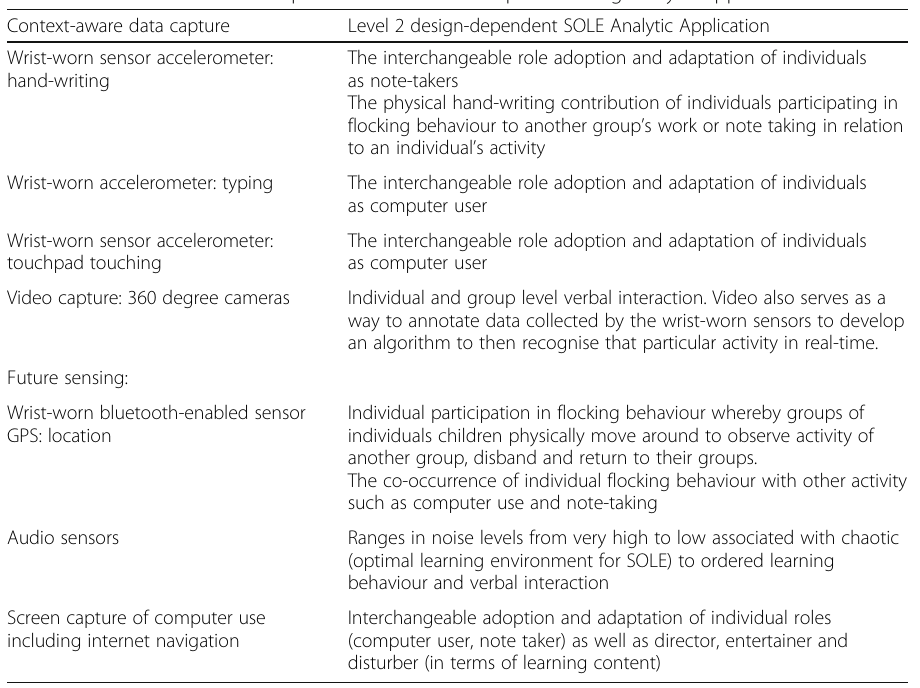
Table 1 Context-aware data capture and its relationship to learning analytic application Context-aware data